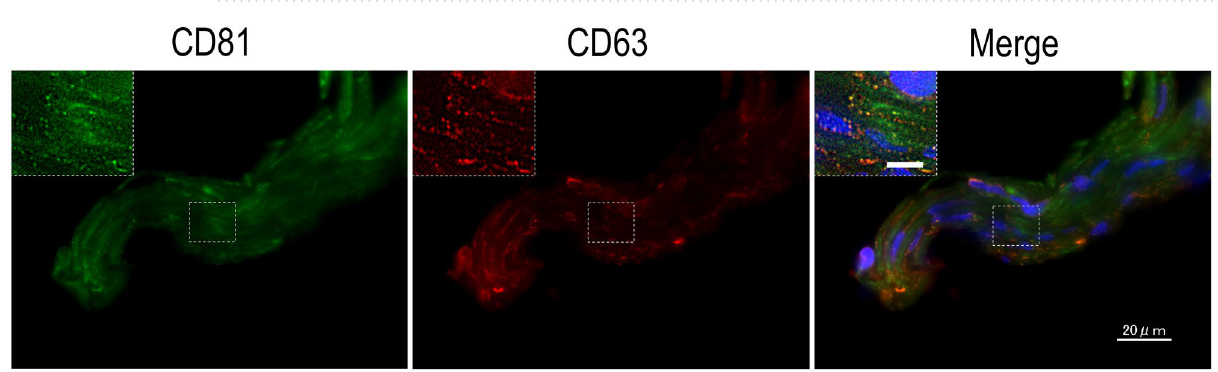
Figure 6. Exosome marker expression in human TM tissues. Representative images of exosome marker expression in excised TM tissues from patients with glaucoma (n = 4). CD81 is indicated in green, CD63 is indicated in red, and nuclei are indicated in blue (DAPI staining). Scale bars: 20 µm. The high-magnification image of the area enclosed by the white dotted square is shown in the upper left area of each panel. Scale bar: 5